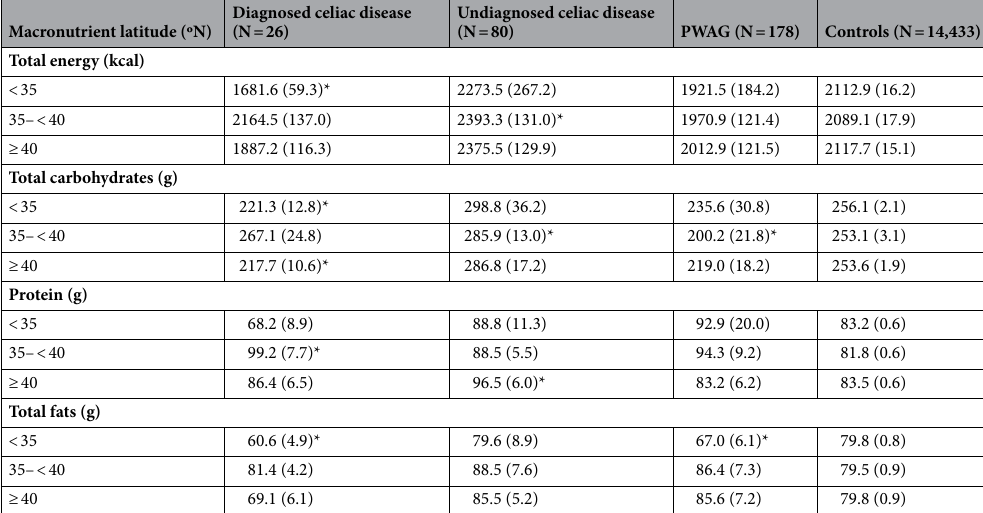
Diagnosed celiac disease (N =